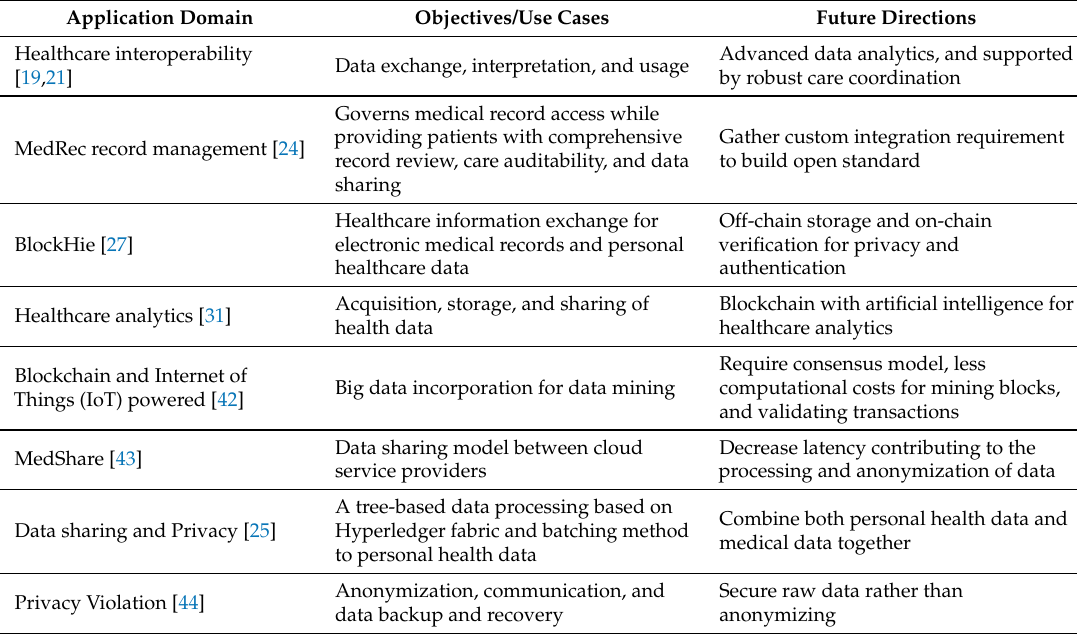
Table 2. Blockchain use cases, design challenges, and future directions in